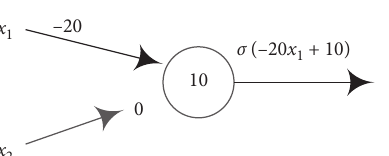
� w � − 20 and b � 30. 1 2